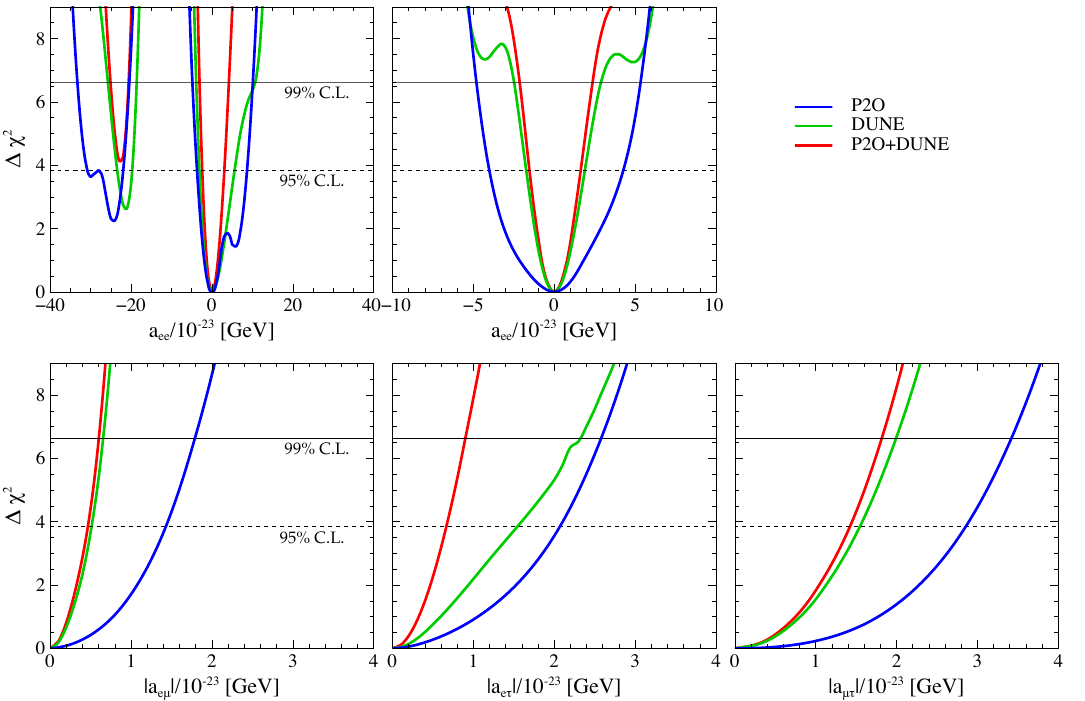
Figure 9 . Expected sensitivity of P2O (blue) and the combined (P2O+DUNE) (red) analysis to the LIV parameters. The black dotted (solid) line indicates the 95% ( 99% ) C.L. at 1 degree of freedom. Each panel corresponds to individual LIV